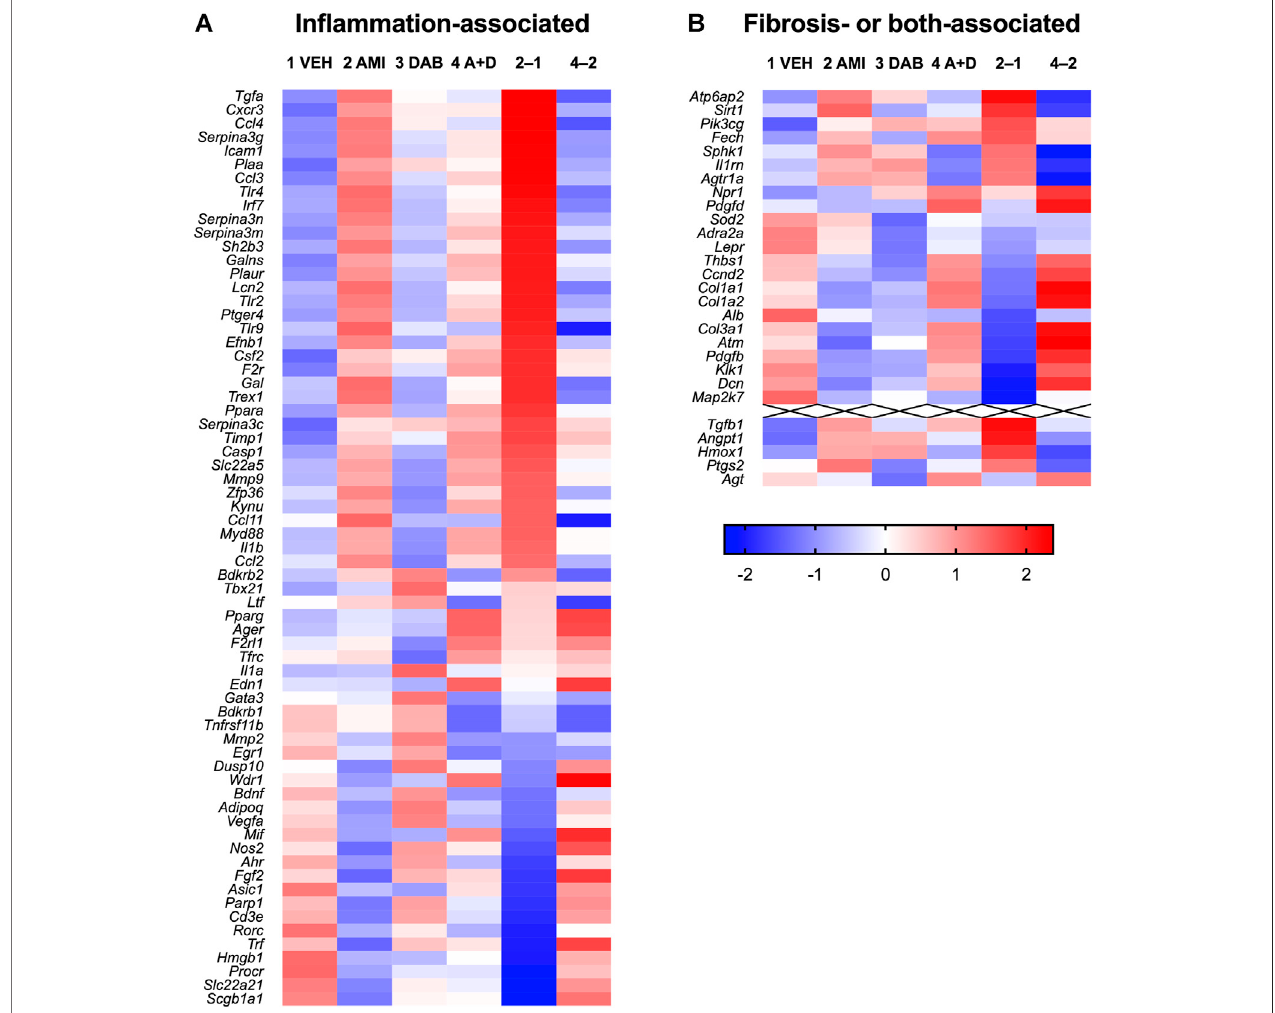
FIGURE 4 | Heatmap ofgene expression inthe lungtissue (onday 26) ofmice treated withvehicle(1 VEH),amiodarone (2 AMI), dabigatran(3 DAB), oramiodarone + dabigatran(4A + D).Log2-expressionvaluescalculated fromRNA-Seqresultsare standardizedacross treatment groups. Red and blue colors represent largerand smaller, respectively,standardizedvaluesin Z scores.Inaddition,thedifferencesbetweenAMIandVEHgroups(2 – 1)andA+DandAMIgroups(4 – 2)areshown.Genesareordered by the difference between the AMI and VEH groups (2 – 1) from high to low separately in in fl ammation- (A) and fi brosis- or both- (B) associated gene sets.